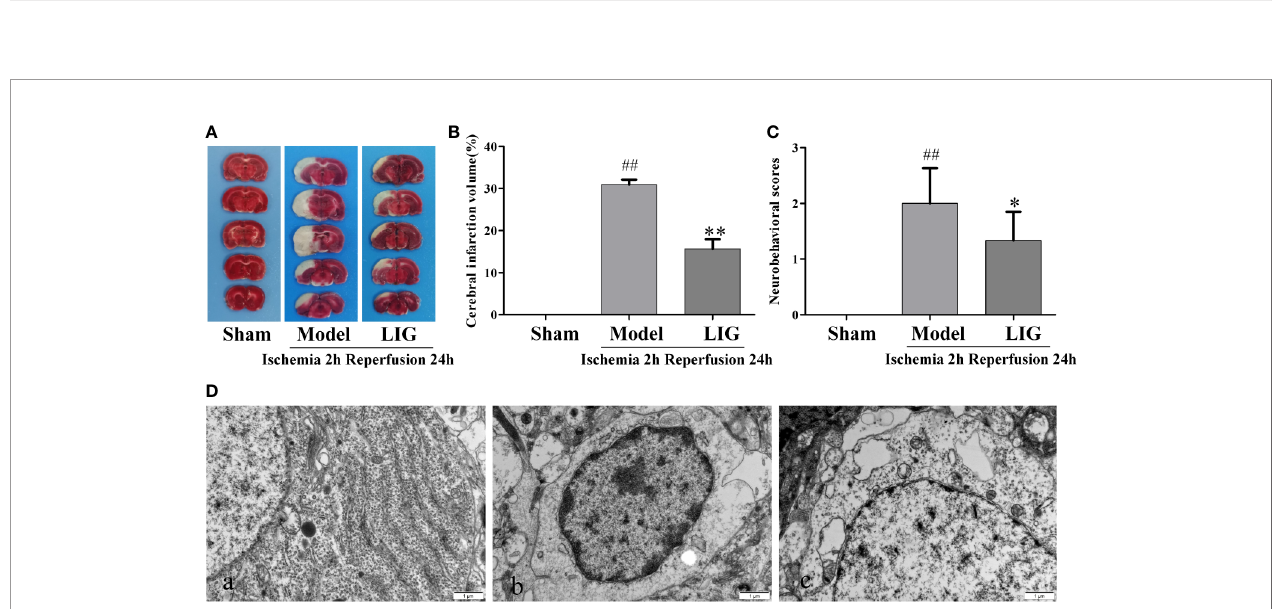
FIGURE 5 | Effects of ligustilide(LIG) on cerebral infarct volume and neurological de fi cits in rats induced by cerebral ischemia injury. (A) Cerebral infarct volumes were determined by TTC staining. The pale area represents infarct area and red color stained area represents normal area. (B) Quantitative analysis of brain infarct volume. (C) Effect of LIG on neurological de fi cits in cerebral ischemia rats at the seventh day. Values are means ± SD (n = 10). (D) The postischemic ultrastructure of hippocampal neurons after LIG administration was examined by TEM (×20000). (a) Sham group; (b) Model group; (c) I/R+LIG (20 mg/kg) group. All data are expressed as mean ± SD, n = 10, ## p < 0.01 vs. sham group, * p < 0.05, ** p < 0.01 vs. model group.